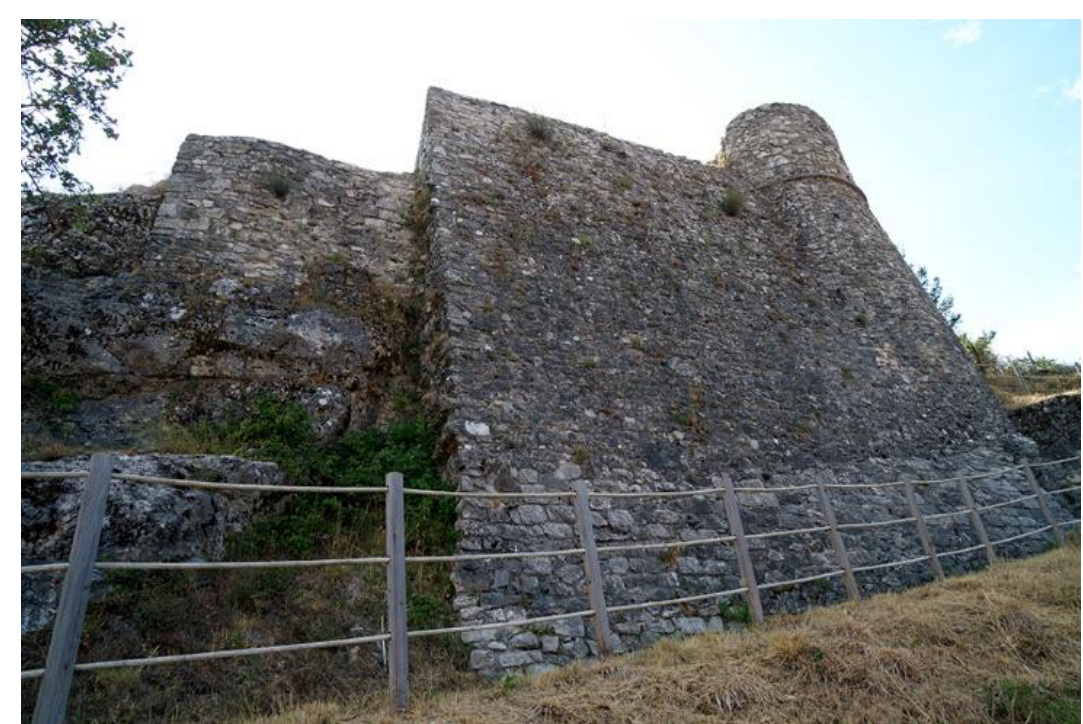
Figure 70. Pescopagano: ruins of the medieval castle (photos by [35,36]).